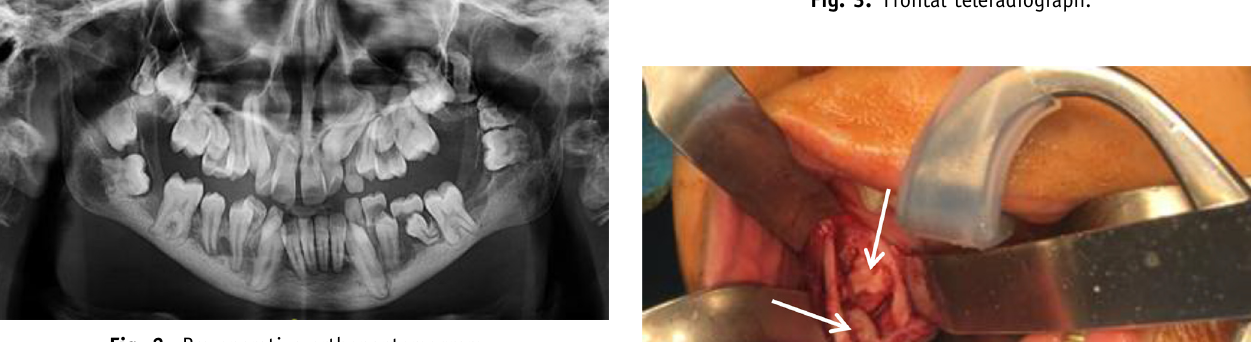
Fig. 2. Pre operative orthopantomogram.